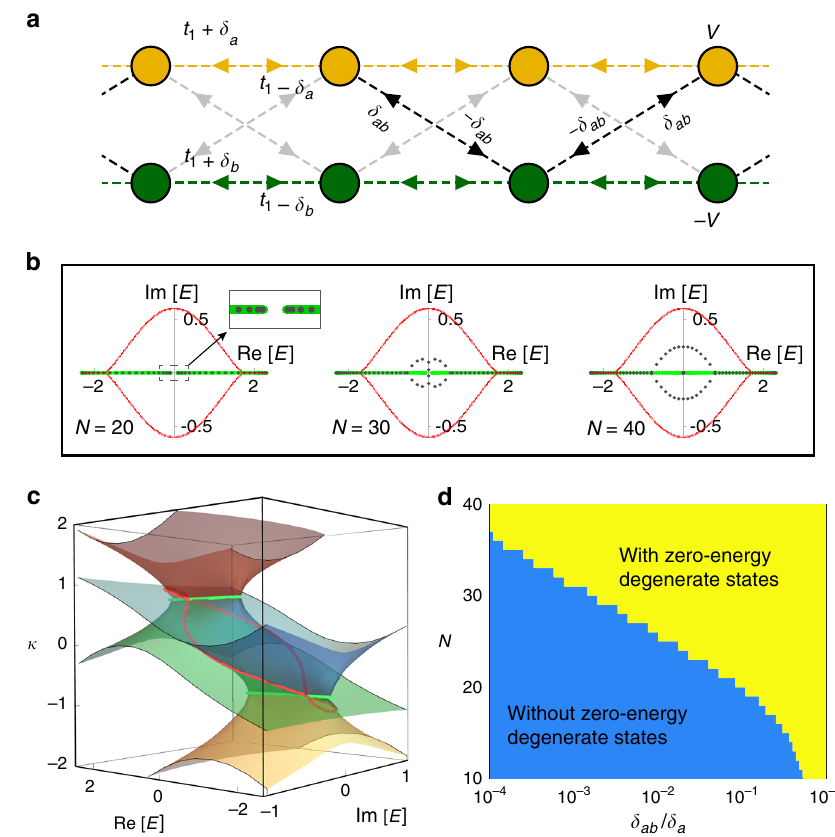
Fig. 4 Topological transition induced by changing the system ’ s size. a Sketch of the H CNHSE-SSH model with cross inter-chain non-reciprocal couplings ± δ ab . b Open-boundary spectra (black dots) at N = 20, 30, and 40 unit cells and coupling δ ab = 0.5 × 10 − 3 . The main part of the spectrum in each case behaves similarly as the model in Fig. 2b, except for a pair of topological edge states blue emerging within the point gap at zero energy. The open-boundary E ∞ spectrum is given by green and red colors in the decoupled and coupled thermodynamic limits respectively. Other parameters are t = 0.75, and V = 1.2. c κ solutions (red, blue, green, and yellow surfaces) of f ( z , E ) = 0 as a function of the complex energy, with the same parameters in 1 b . Intersecting regions (green and red dotted lines) give the open-boundary skin solutions of the system in the thermodynamic limit. Among them, green lines correspond to the skin solutions of two decoupled chains at δ ab = 0. The solutions of red curves emerge at a small but nonzero δ ab , and the skin solutions of the weakly coupled system are given by the intersecting regions with the smallest ∣ κ ∣ , i.e., the red loop in the center and green lines at the two ends with large and small Re ½ E (cid:2) . d Emergence of in-gap degenerate modes as a function of δ ab / δ a and N with δ a = − δ b = 0.5, t 1 = 0.75, and V = 1.2, with the plotted boundary scaling logarithmically with N .